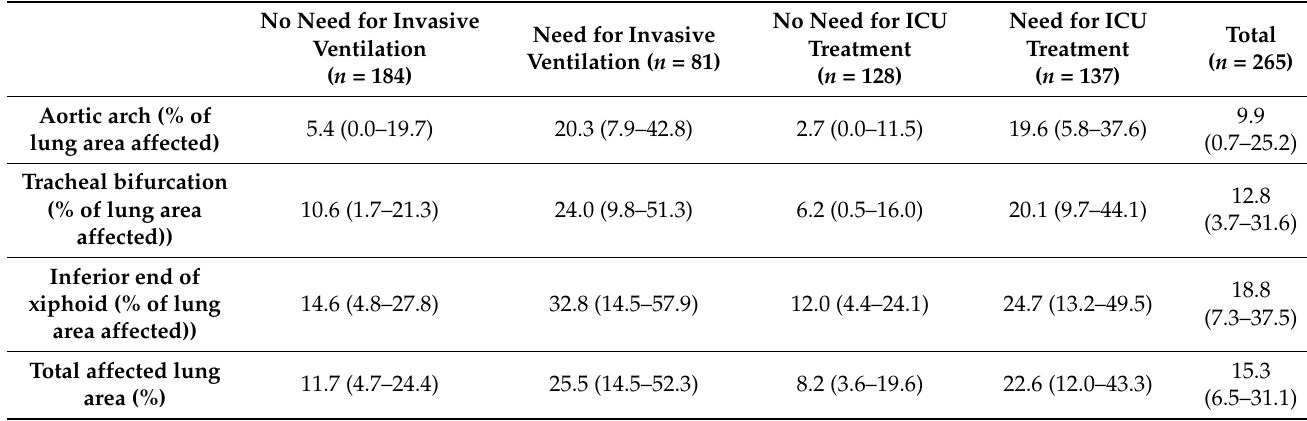
Table 3. Simple semiquantitative (SSQ) assessment. Total affected lung area was calculated from all three levels at which involvement was measured. Patients with need for ICU admission or invasive ventilation were affected more severely, especially the cranial segments of the